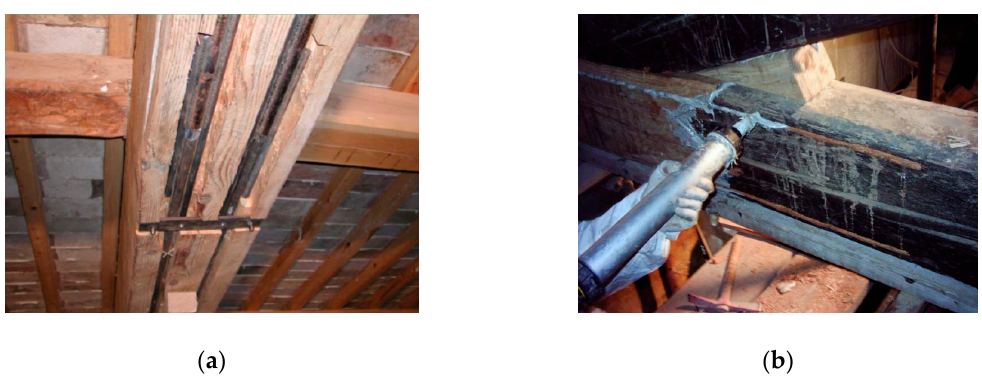
Figure 25. Bonded-in steel bar reinforcement: ( a ) detail of the reinforcement before resin application; ( b ) filling of the grooves with epoxy paste.